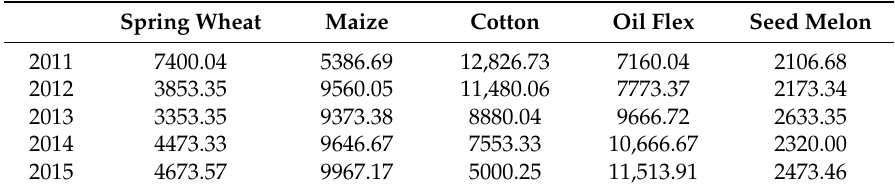
Table 1. Summary of crop acreage from 2011–2015 in Minqin County (unit: hm 2 ). Spring Wheat Maize Cotton Oil Flex Seed Melon